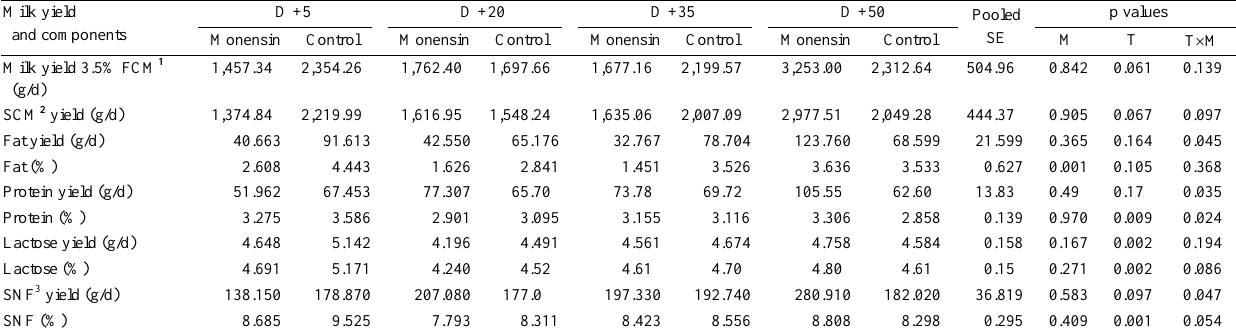
Table 5. Comparison of least square of means (LSMs) and standard errors (SE) of milk composition parameters between Saanen does receiving monensin and controls not receiving it Milk yield D +5 D +20 D +35 p values and components Monensin Control Monensin Control Monensin Control Monensin Control M T T  M Milk yield 3.5% FCM 1 (g/d)